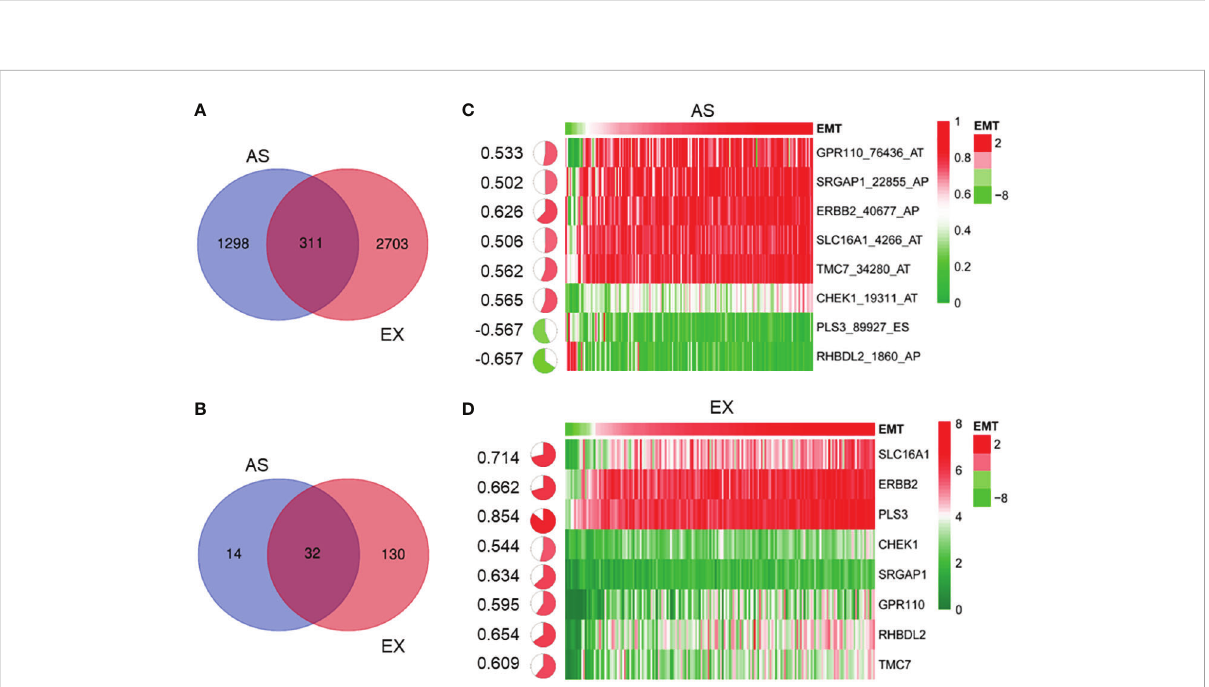
FIGURE 3 Identi fi cation of gene alternative splicing event associated with EMT in PDAC. (A) Venn diagram shows 311 genes whose mRNA levels and AS events are associated with prognosis (p < 0.01). (B) Venn diagram shows 32 genes whose mRNA levels and AS events were closely related to the EMT signature. (C) According to average AS value of between 0.2 and 0.8, heatmap shows that eight gene AS events were signi fi cantly related to the GSVA score of EMT (C) and eight genes whose mRNA levels were signi fi cantly related to the GSVA score of EMT (D) . EMT, epithelial-to- mesenchymal transition; PDAC, pancreatic ductal adenocarcinoma; AS, alternative splicing; GSVA, gene set variation